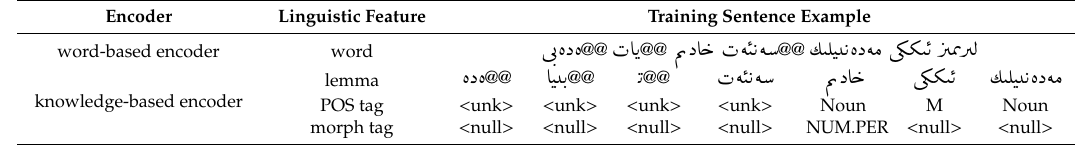
Table 3. The training sentence examples for Uyghur–Chinese machine translation